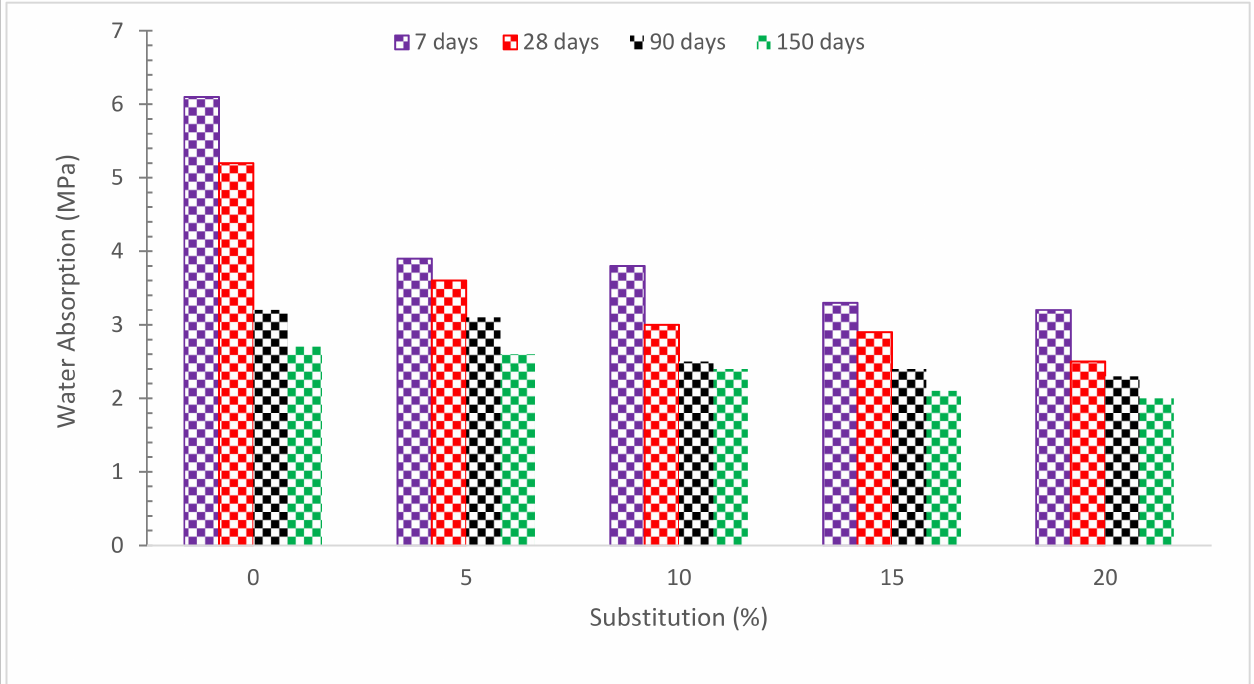
Figure 15. Water Absorption